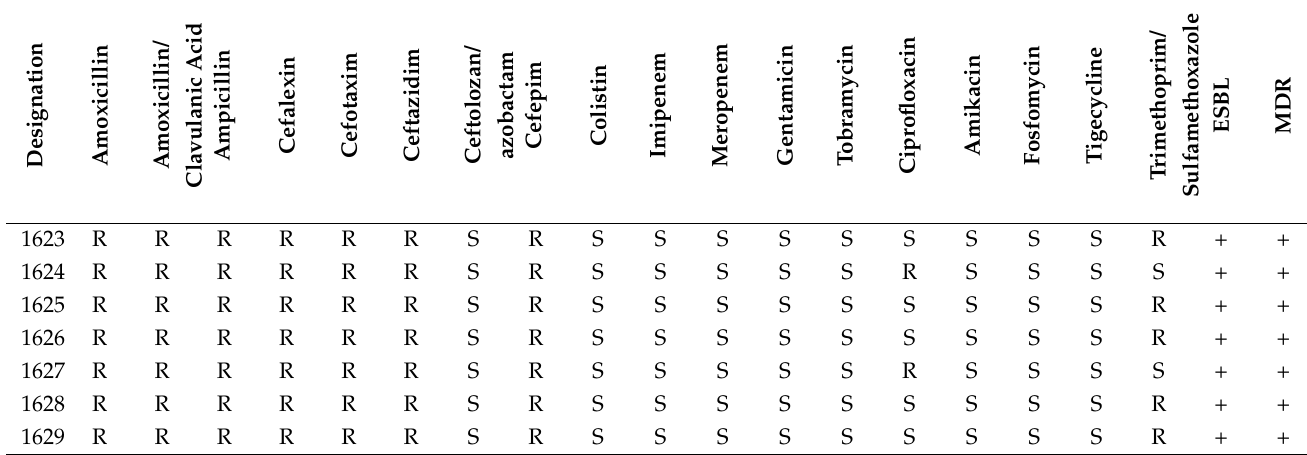
Table 2. Phenotypic resistance profiles of ESBL- E. coli isolates. R = resistant, S =